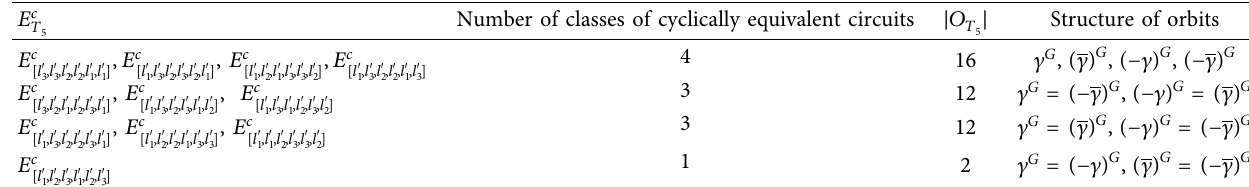
Table 7: Cyclically equivalent classes of T